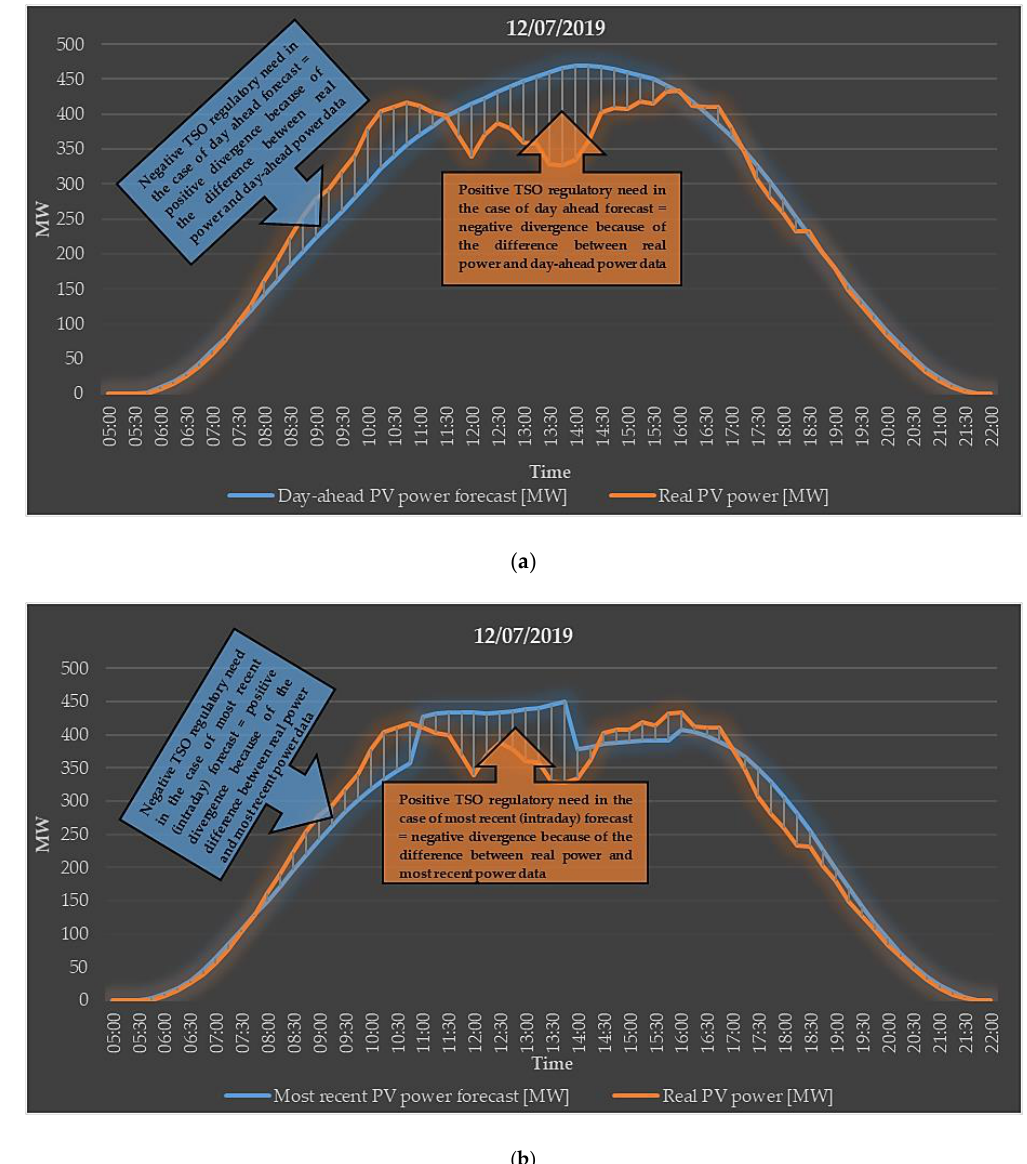
Figure 4. Explanation of the interpretation of real, day-ahead ( a ) and most recent ( b ) PV power by a transmission system operators (TSO) and a PV system operator based on real data of a 1000-MWp PV system [82].